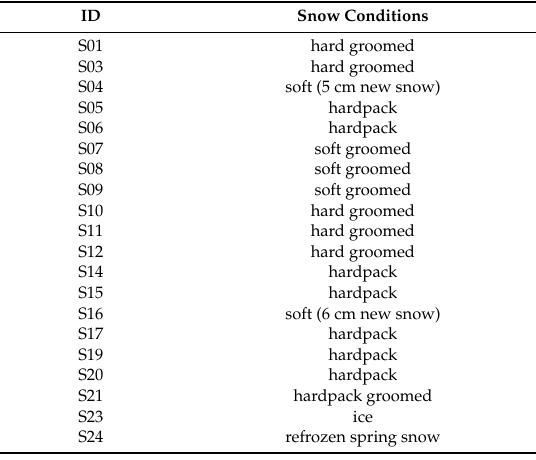
Table A5. Gives an overview of the snow conditions during data